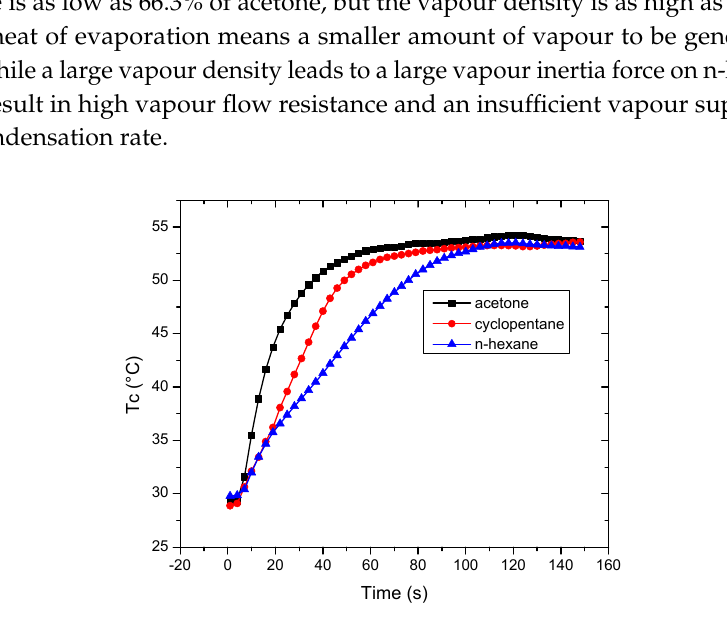
Figure 7. Start-up performance of the MF-AHPAs with different working fluids.